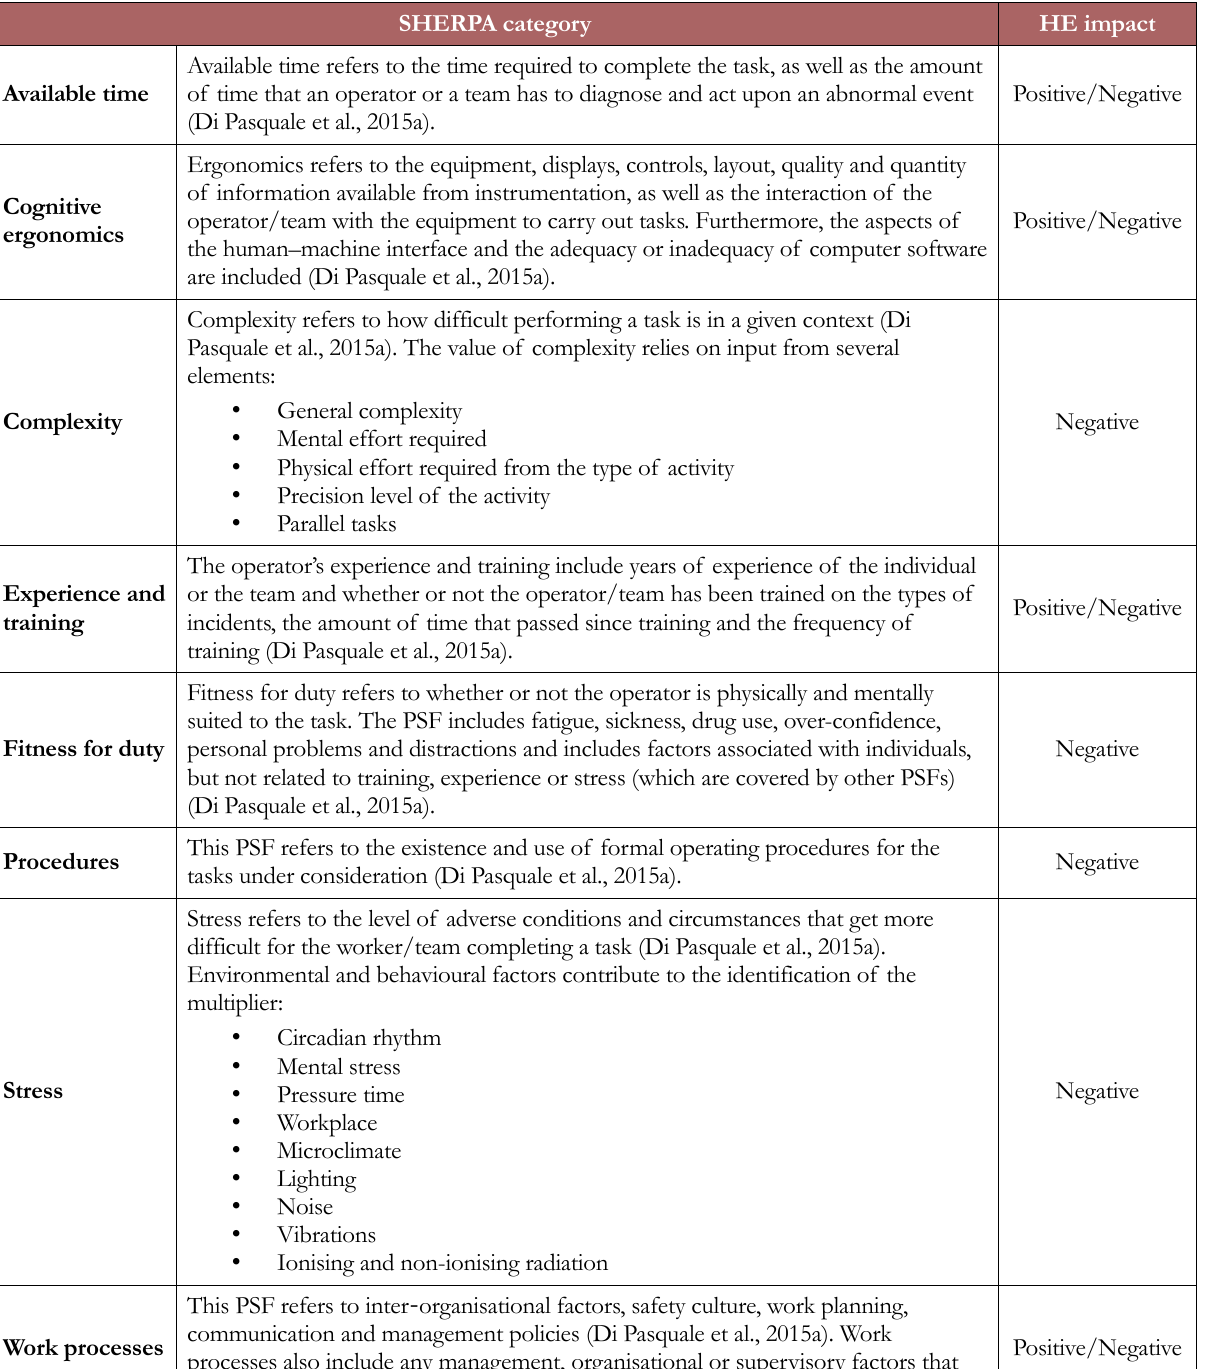
Step 2 provided the main areas of investigation in the field of human error in maintenance defined through brainstorming among the authors following the reading of the papers with different perspectives. Therefore, the maintenance, PSFs and maintenance error